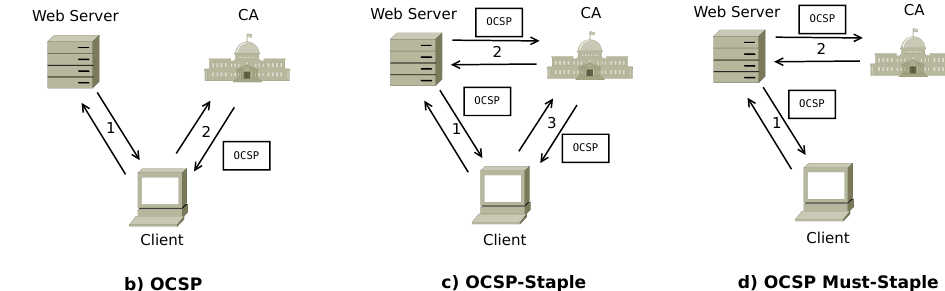
Figure 1. Certificate revocation (Based on